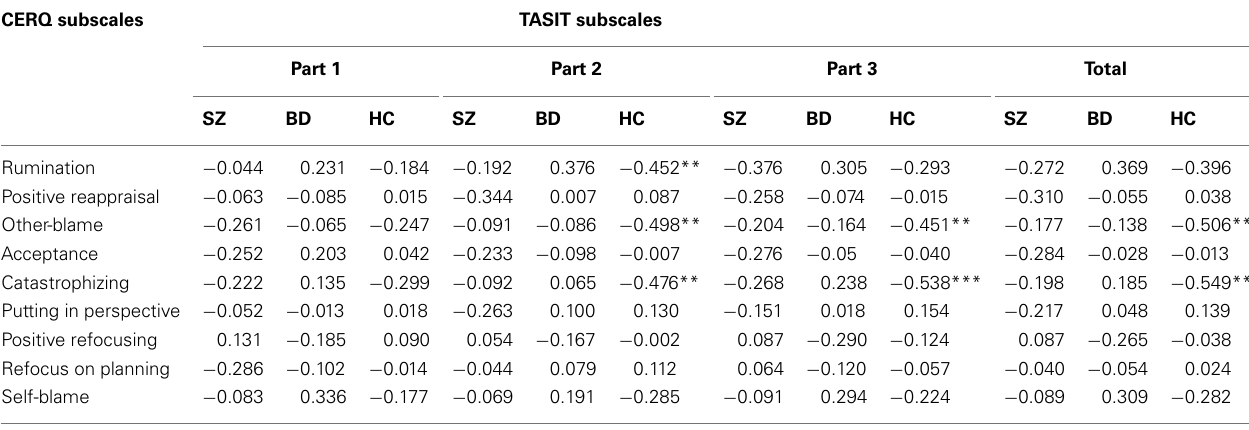
Table 5 | Pearson’s two-tailed correlations betweenTASIT scores and CERQ strategies for SZ, BD, and HC groups. CERQ